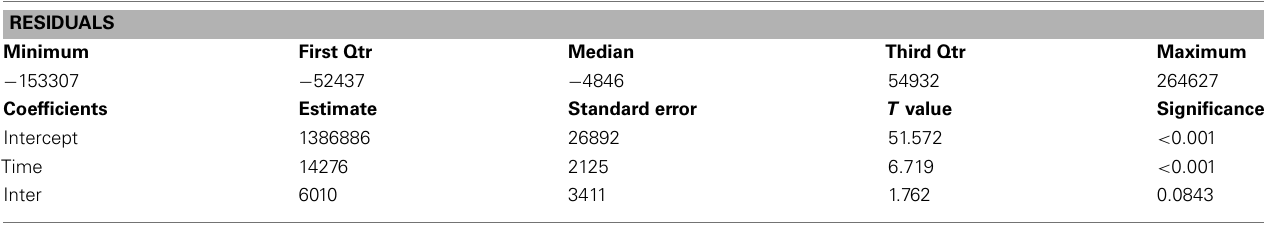
Table 2 | Residuals and coefficients for the change in the utilization of other antidepressants before and after generic ER venlafaxine. RESIDUALS